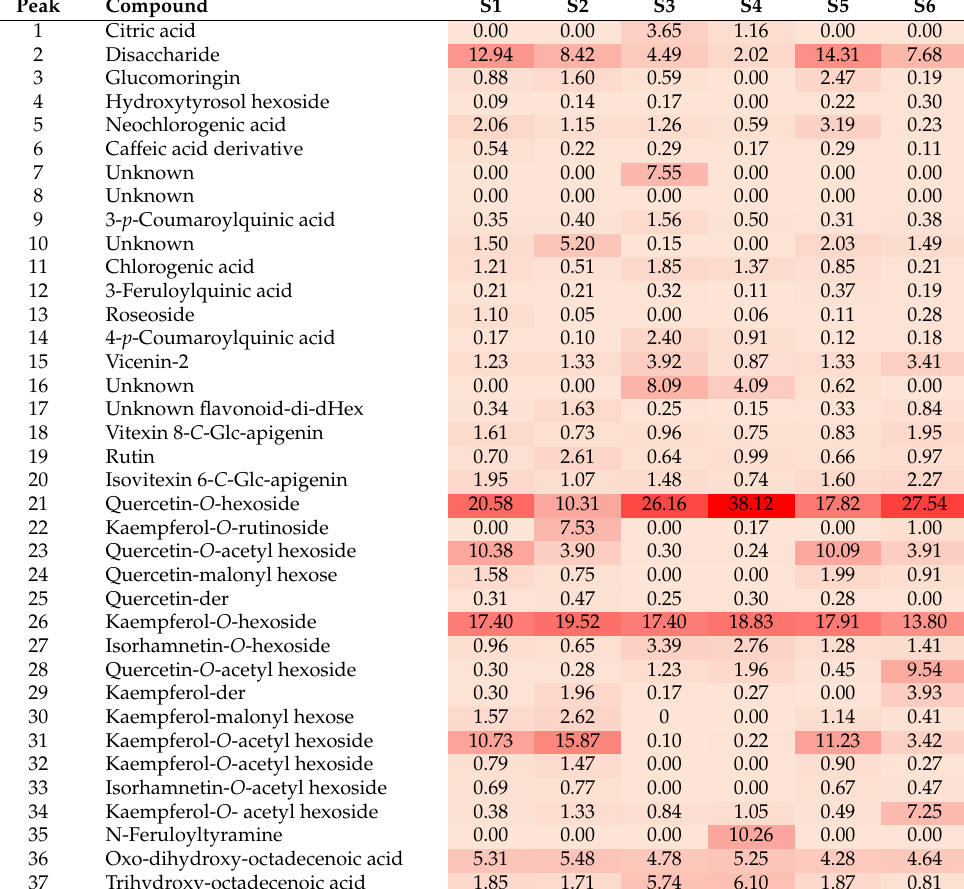
Table 4. Relative peak areas and heat map of extracts of M. oleifera food supplements.